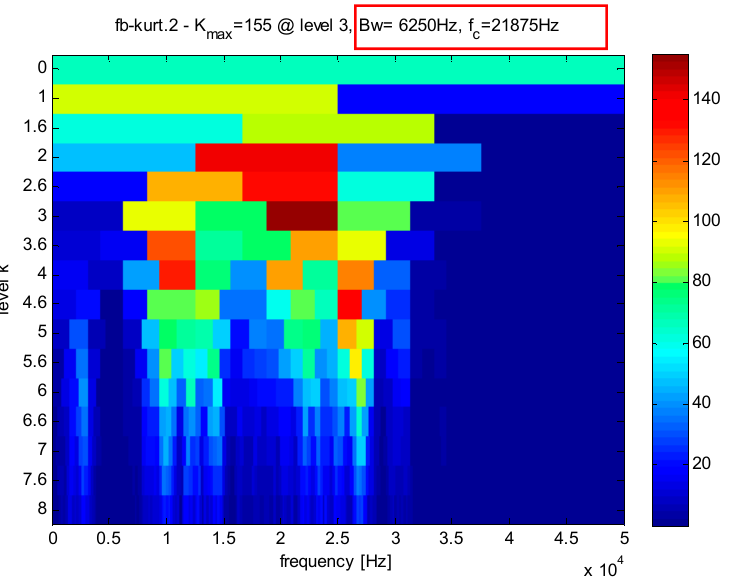
Figure 12. Kurtogram of the signals as shown in Figure 7.